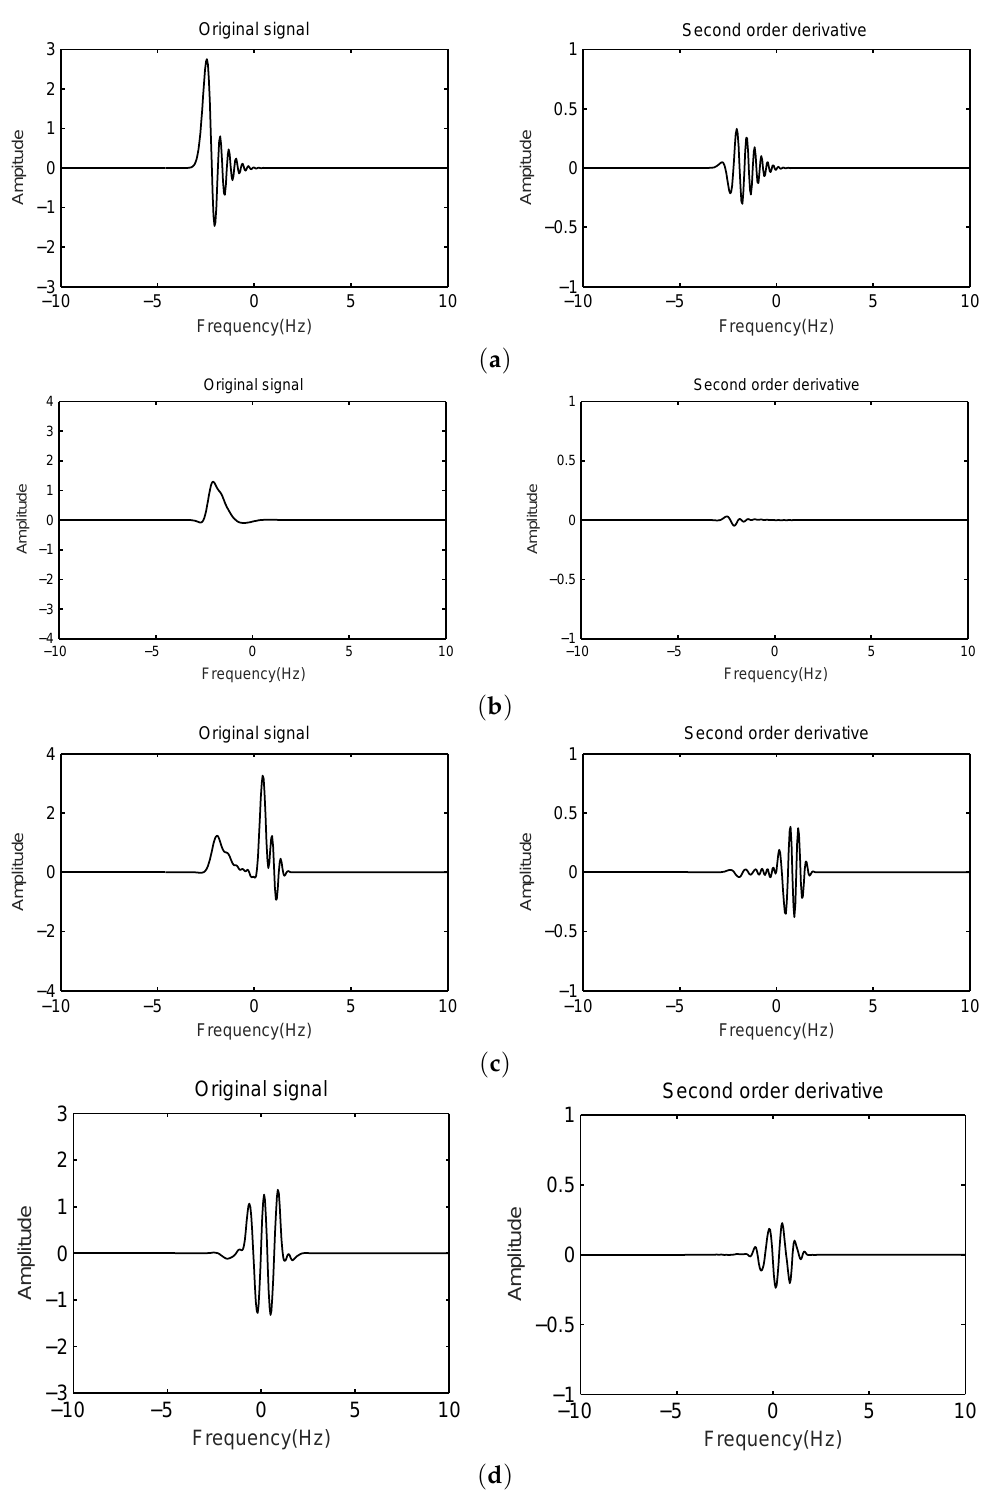
Figure 3. ( a ) is peak amplitude and second order derivative of mono-component signal; ( b ) is falling edge amplitude and second order derivative of mono-component signal; ( c ) is non-cross terms amplitude and second order derivative of multi-component signal; ( d ) is cross terms amplitude and second order derivative of multi-component